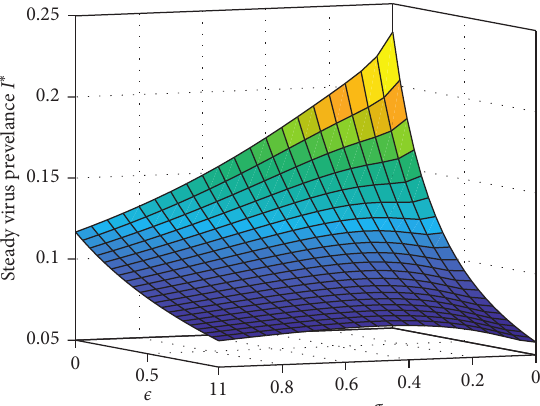
Figure 7: An illustration of the effect of β and η